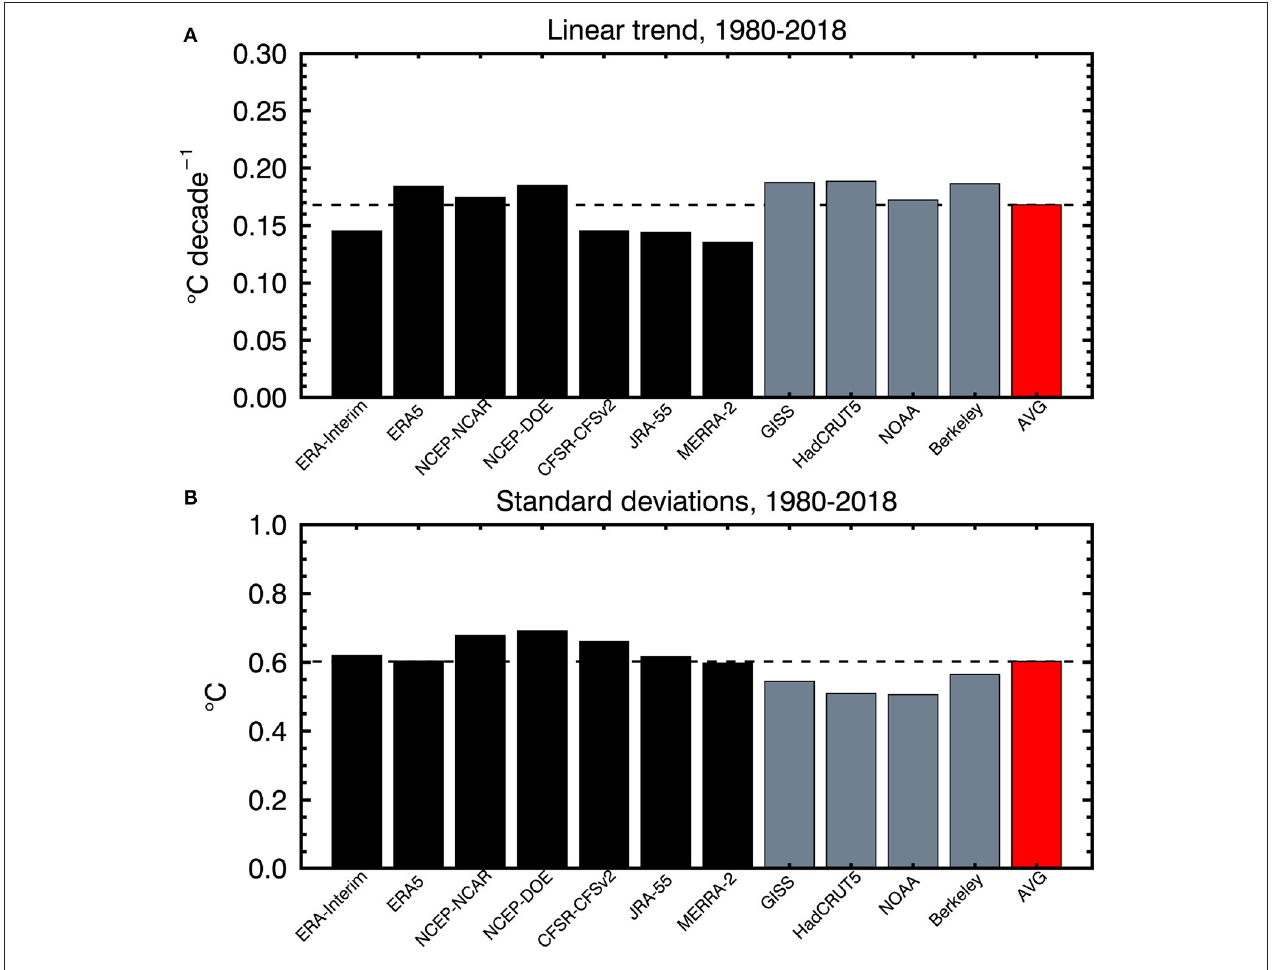
σ 2 X of globally averaged annual mean temperature from the reanalyses (black) and station-based rD k E